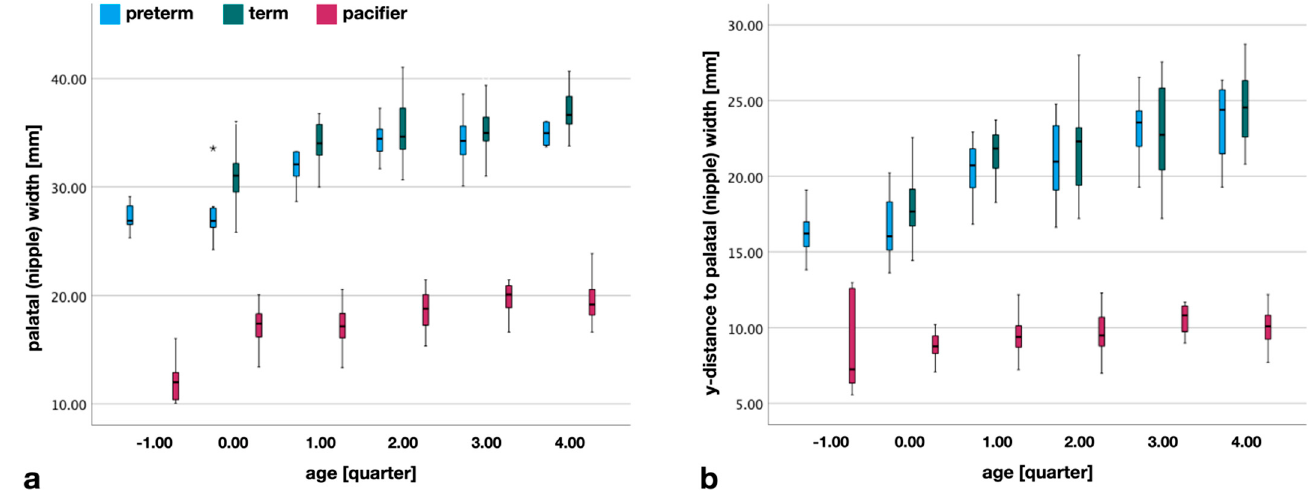
Figure 6. ( a ) Palatal width ( pw ) and artificial nipple width ( npw ). The artificial nipple widths show no similarities to the palates. Despite a small increase over time, a growth pattern is not visible. Preterm pacifiers are particularly narrow in dimension. ( b ) Location of the widest part of the infant’s palate and artificial nipples. Distance in the horizontal (y-) direction from the anteriormost to the widest part of the palate (preterm, term) and from the lip shield plane to the widest part of the artificial nipple minus lip thickness (pacifier). Although the width changes somewhat, the distance to the lip shield does not seem to have been considered in the design of the pacifiers. (*) extreme outlier.